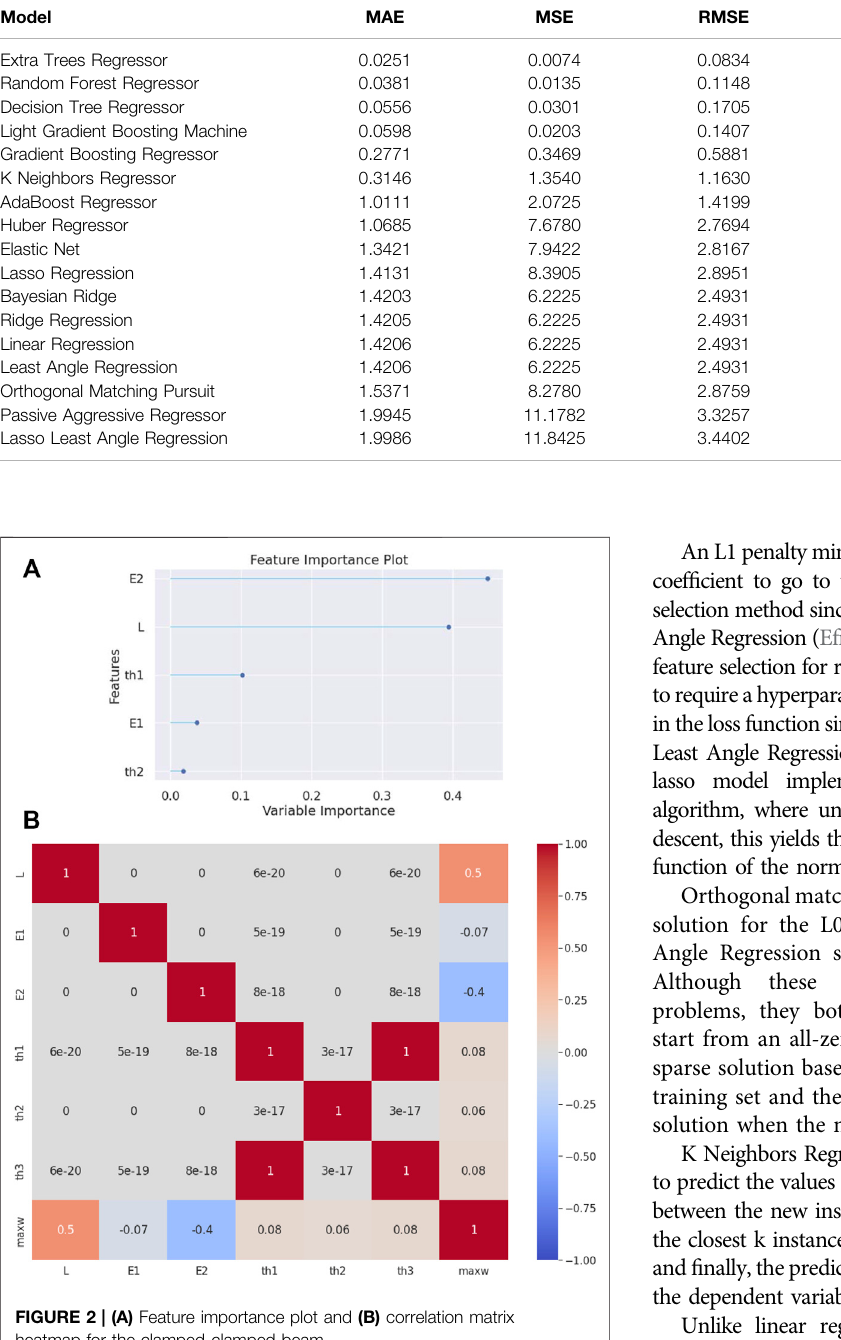
TABLE 2 | Evaluation metrics for the clamped-clamped beam.